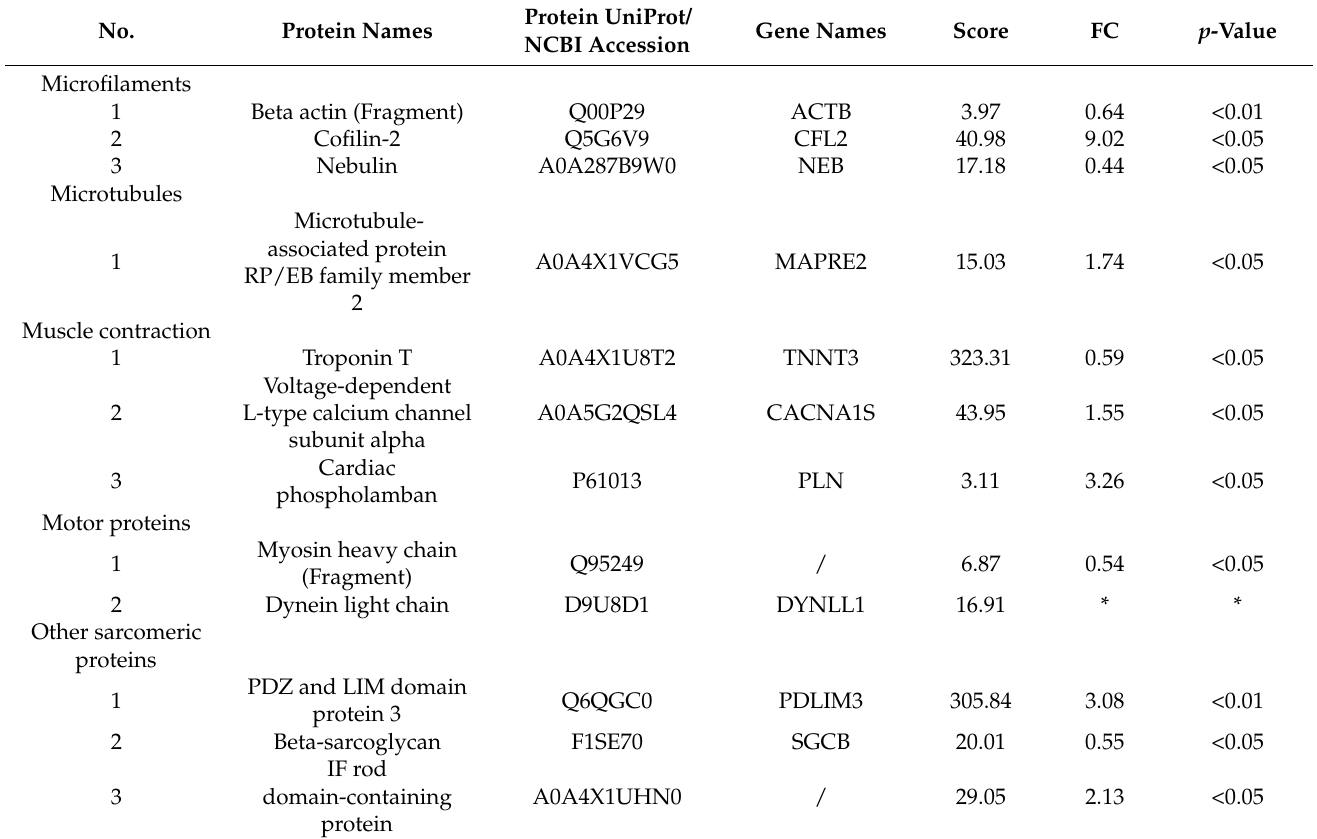
Table 3. Representative differential proteins of pork the myofibrillar fraction between the pale, soft and exudative (PSE), and red, firm and non-exudative (RFN) meat, as identified by LC-MS/MS.